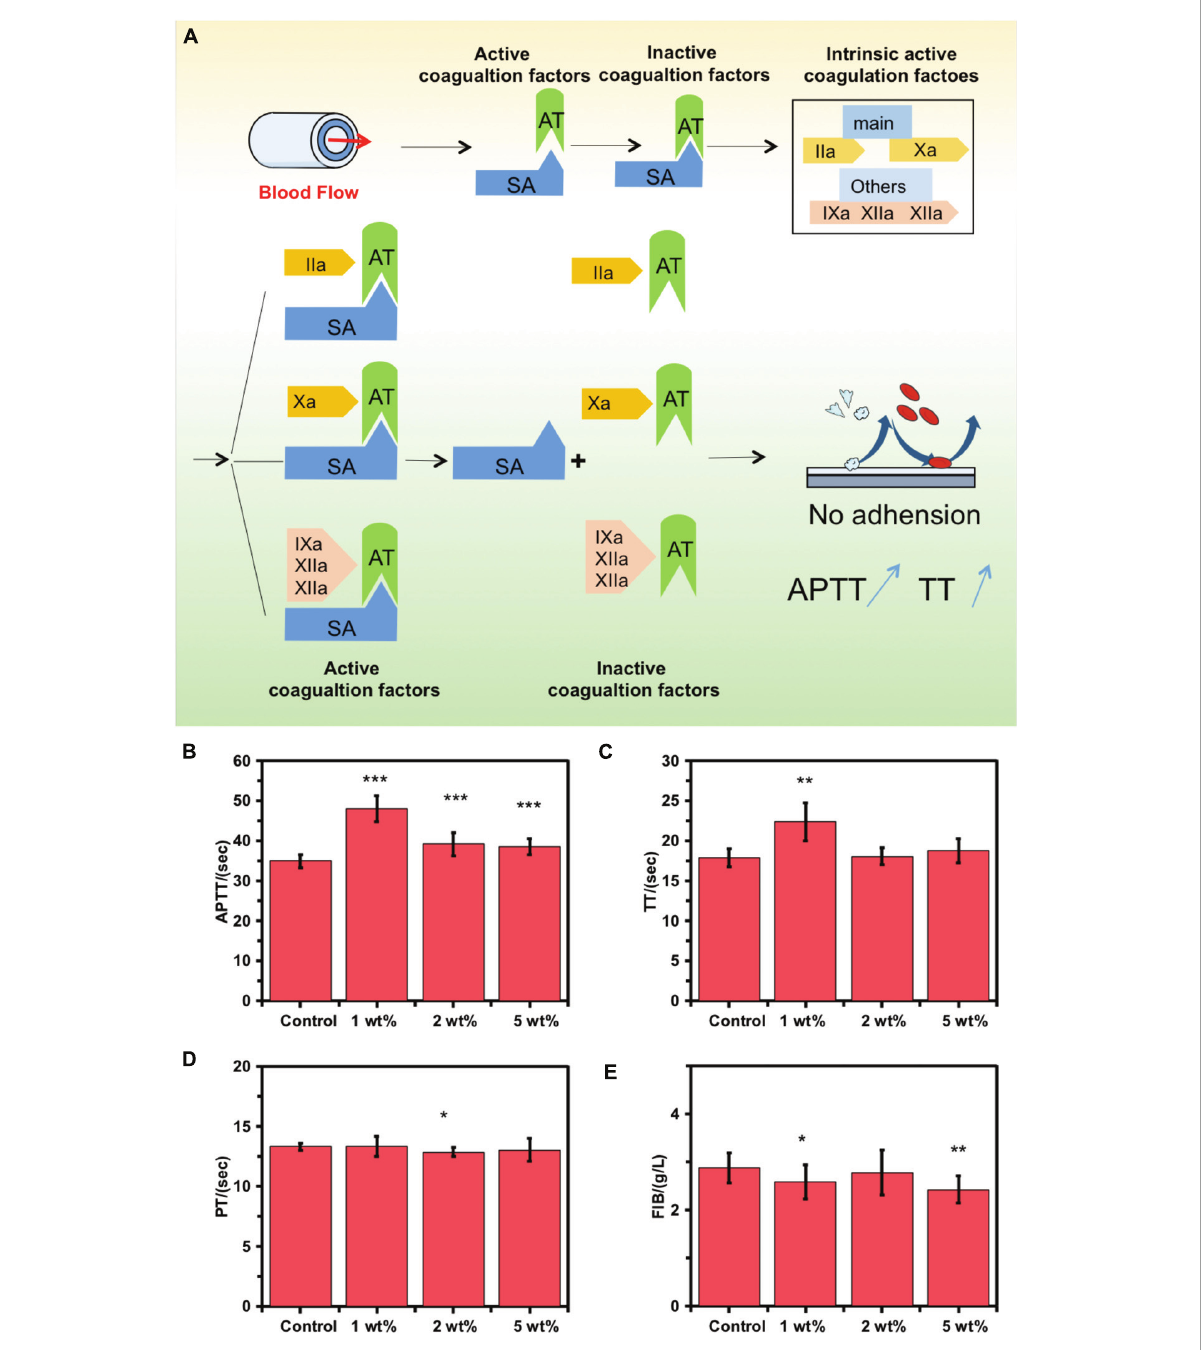
FIGURE3 Coagulation function on the inner surface of control extracorporeal membrane oxygenation (ECMO) and MA-SA-Hydrogel coating tubings. (A) Schematic diagram of anticoagulation mechanism. (B) The activated partial thrombin time (APTT), (C) thrombin time (TT), (D) prothrombin time activity, and (E) fibrinogen amount (FIB) were measured using an automated blood coagulation analyzer and exposed to human blood (*** p < 0.001; ** p < 0.01; * p < 0.05; NS, not